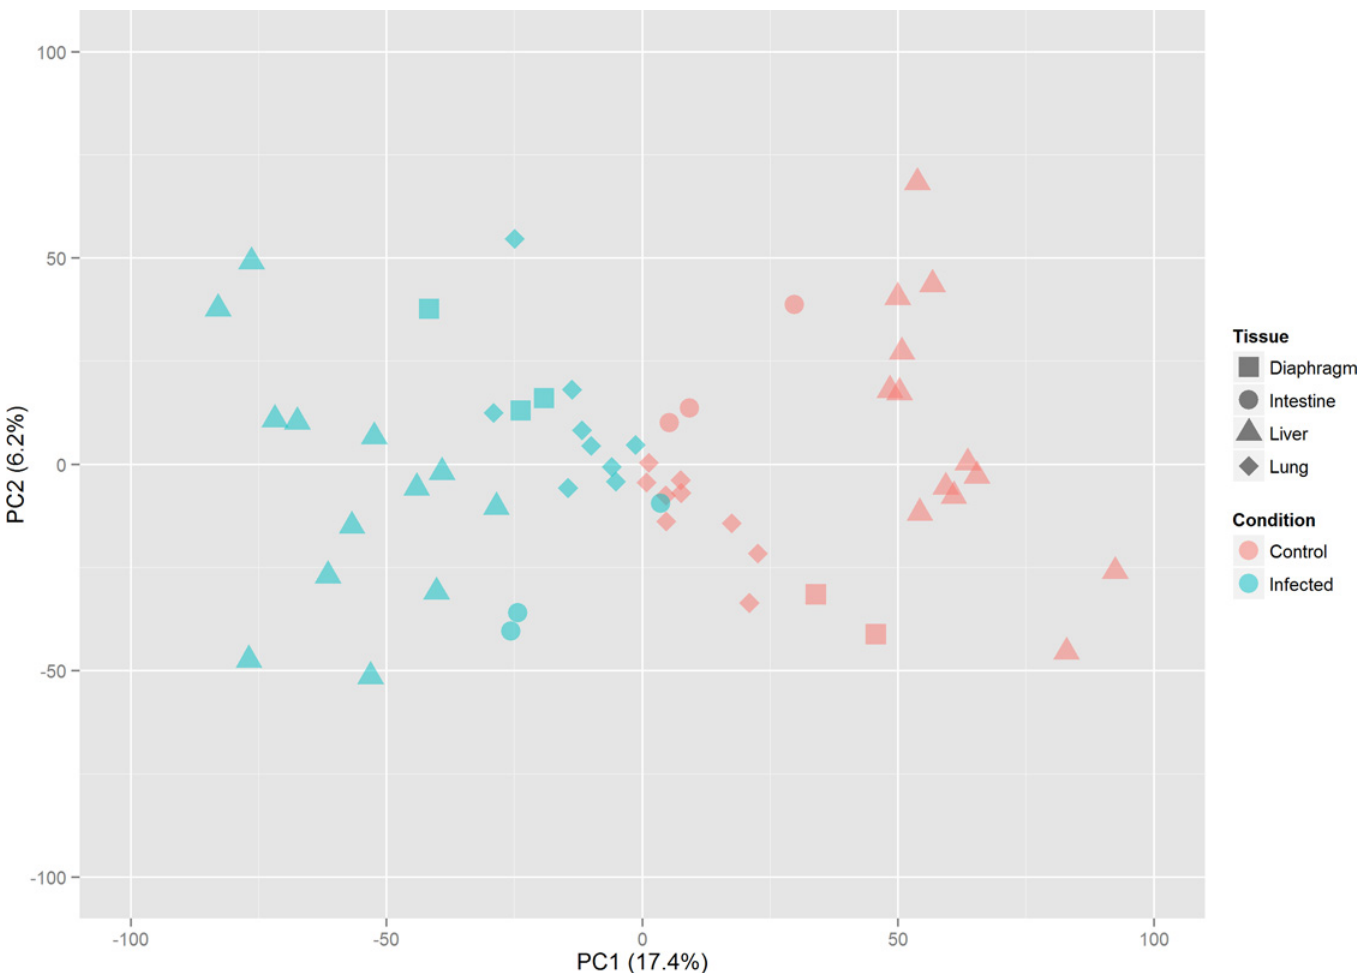
Fig 2. Principal component analysis of the combined dataset after batch effect correction. All samples are represented by different symbols with shapes according to their tissue origins and colors based on their experimental conditions.